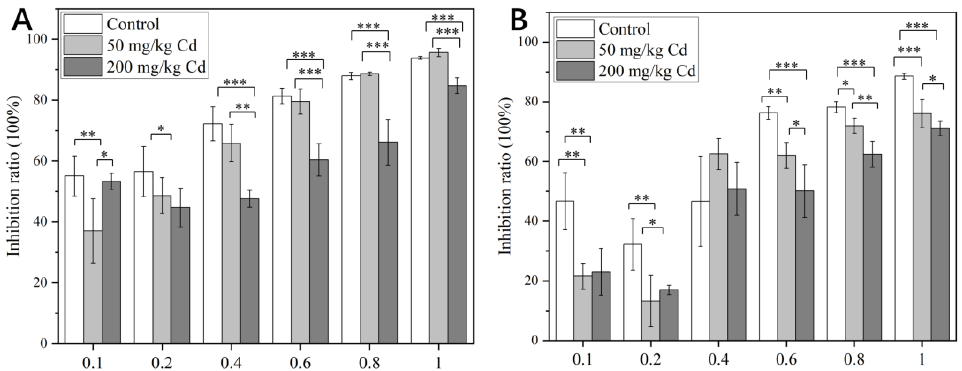
Figure 7. The inhibitory effects of different drug concentrations on HeLa cells ( A ) and L929 cells ( B ). The data show the mean ± SD of three replicates. * means p < 0.05, significant; ** means p < 0.01, very significant; *** means p < 0.001, extremely significant. The drug concentration represented by the pedicel was mg/mL, and the ordinate represented the cell inhibition rate. The greater the value, the greater the cytotoxicity.